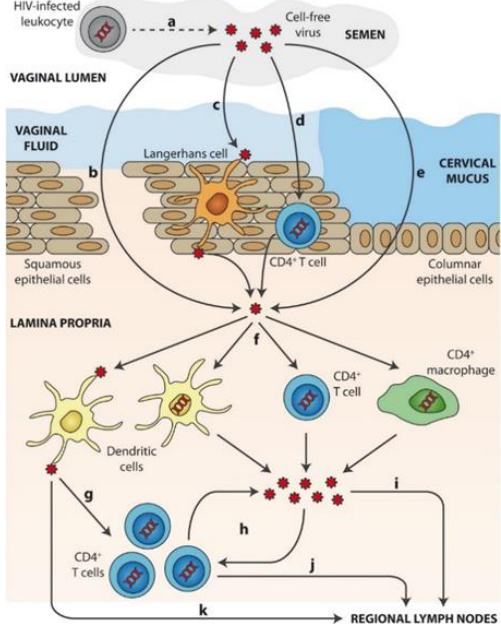
Figure 2. Mechanisms of sexual transmission of cell-free HIV through the cervicovaginal route. Reprinted with permission from [58].